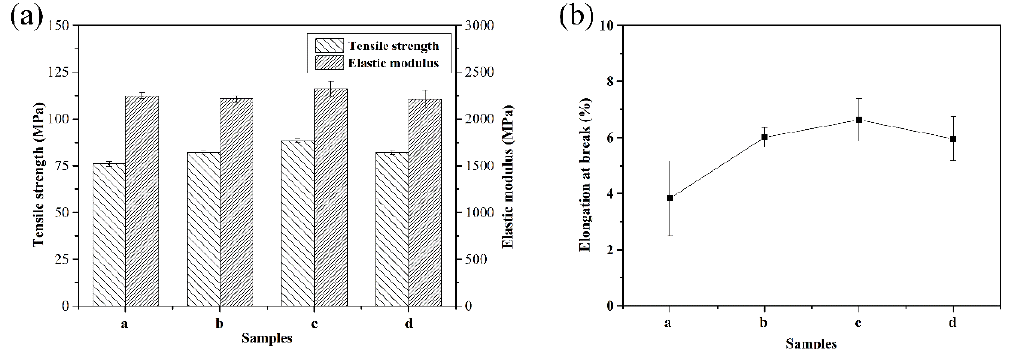
Figure 7. Mechanical properties of PEN–OH films. ( a ) Tensile strength and elastic modulus ( b ) elongation at the break.